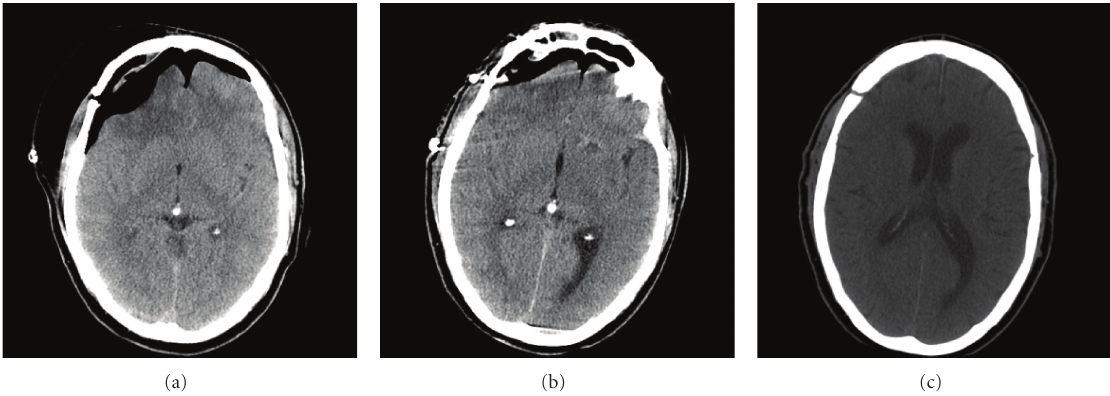
Figure 1: Computerized tomography scans (a) on presentation to the emergency department. There is a subgaleal collection of air in addition to the tension pneumocephalus. (b) After placing the Foley catheter, the subgaleal collection has completely resolved and the tension pneumocephalus has significantly improved. The patient’s symptoms had resolved after Foley placement. (c) 1 month later showing complete resolution of tension